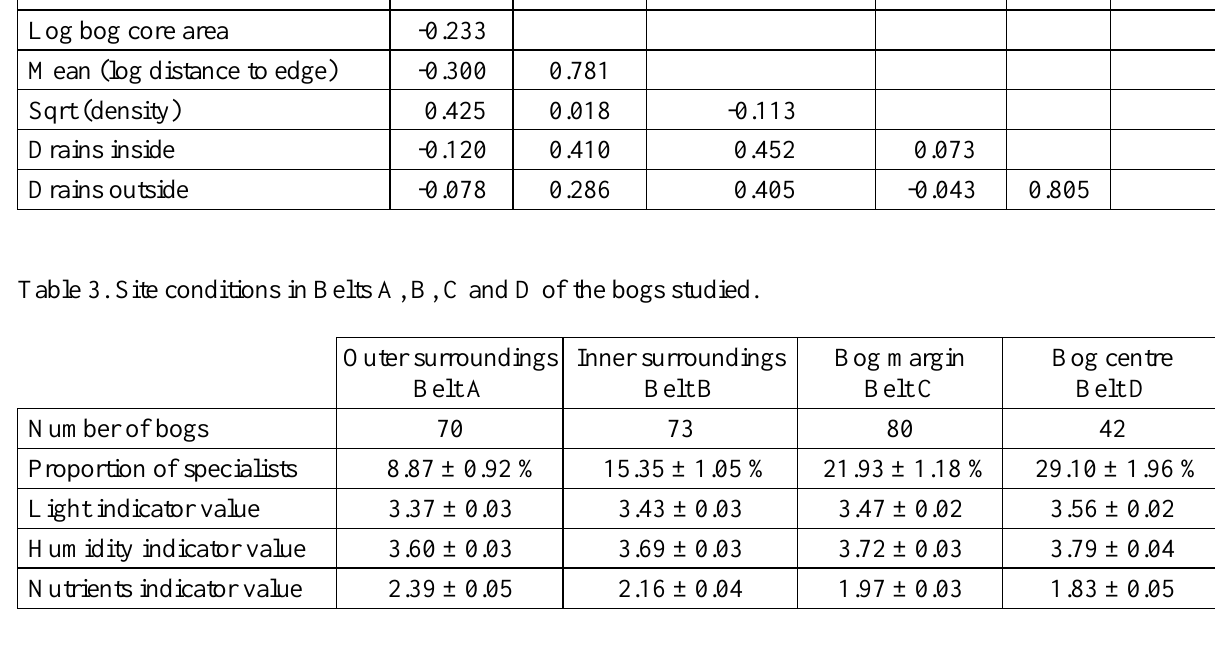
Table 4. Correlations (Pearson’s r) between the proportion of specialists and indicator